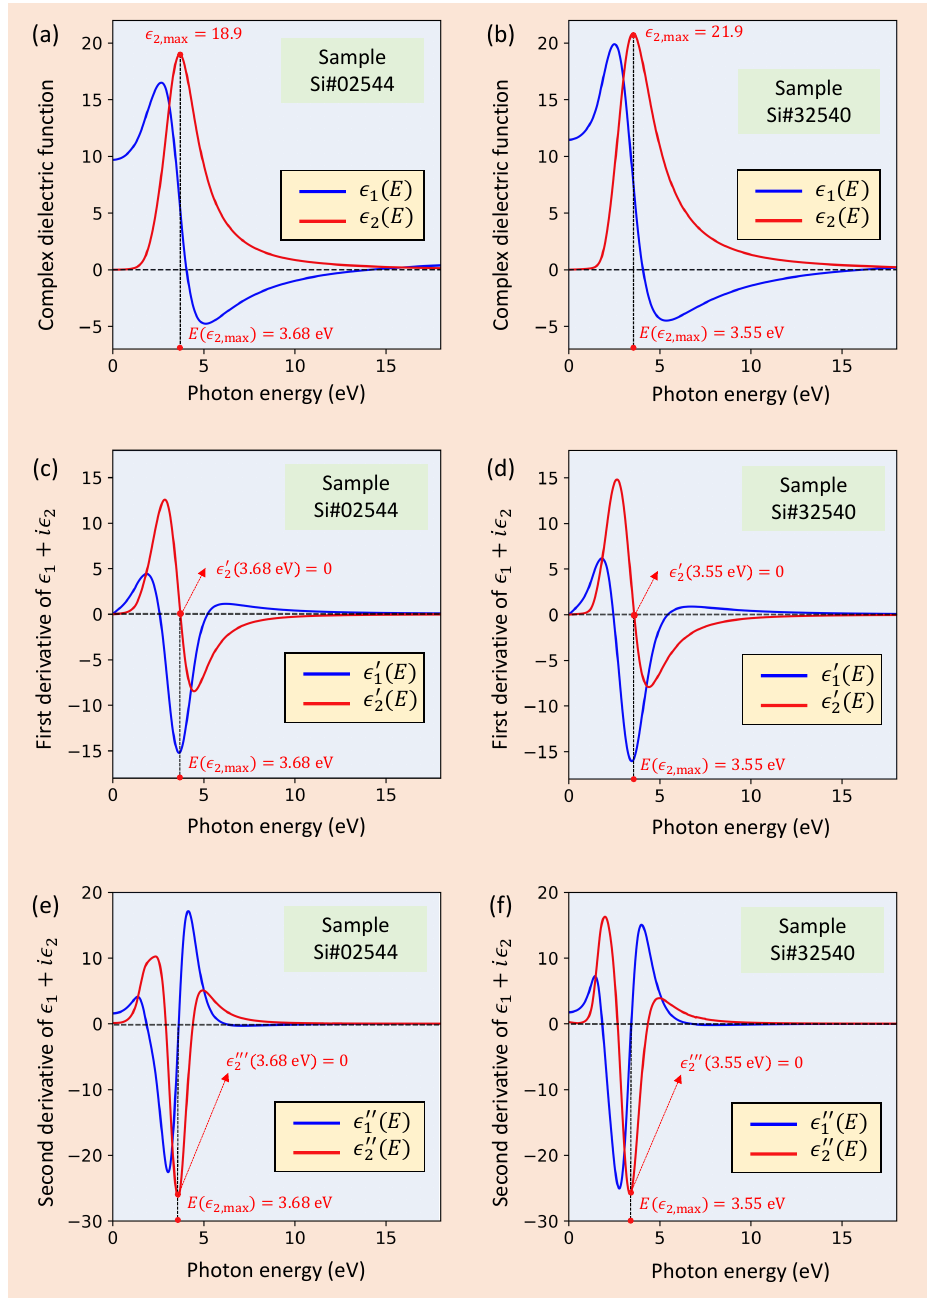
Figure 5. Photon-energy dependence of the real and imaginary parts of the complex dielectric constant of two a -Si thin-film samples: ( a ) Si#02544 and ( b ) Si#32540. Shown also in this figure, the first and second derivative of (cid:101) 1 and (cid:101) 2 ( c – f ), demonstrating that they are certainly twice differentiable, as should be the case considering that the ATLU dielectric function is complex